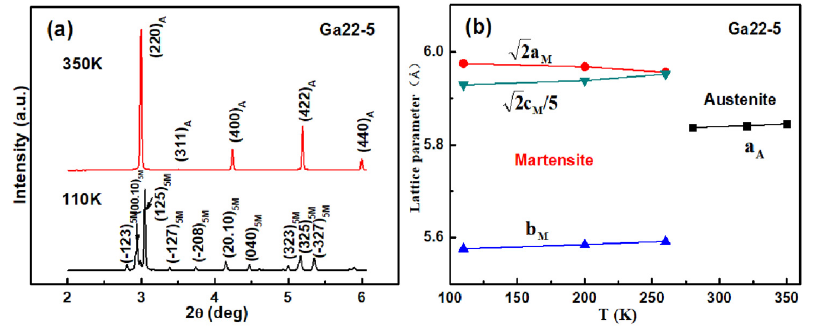
Figure 8. High-energy X-ray diffraction patterns experimentally collected at 350 K and 110 K for the Ga22-5 ( x = 7) alloy ( a ). The temperature dependence of the lattice parameters is shown in ( b ).